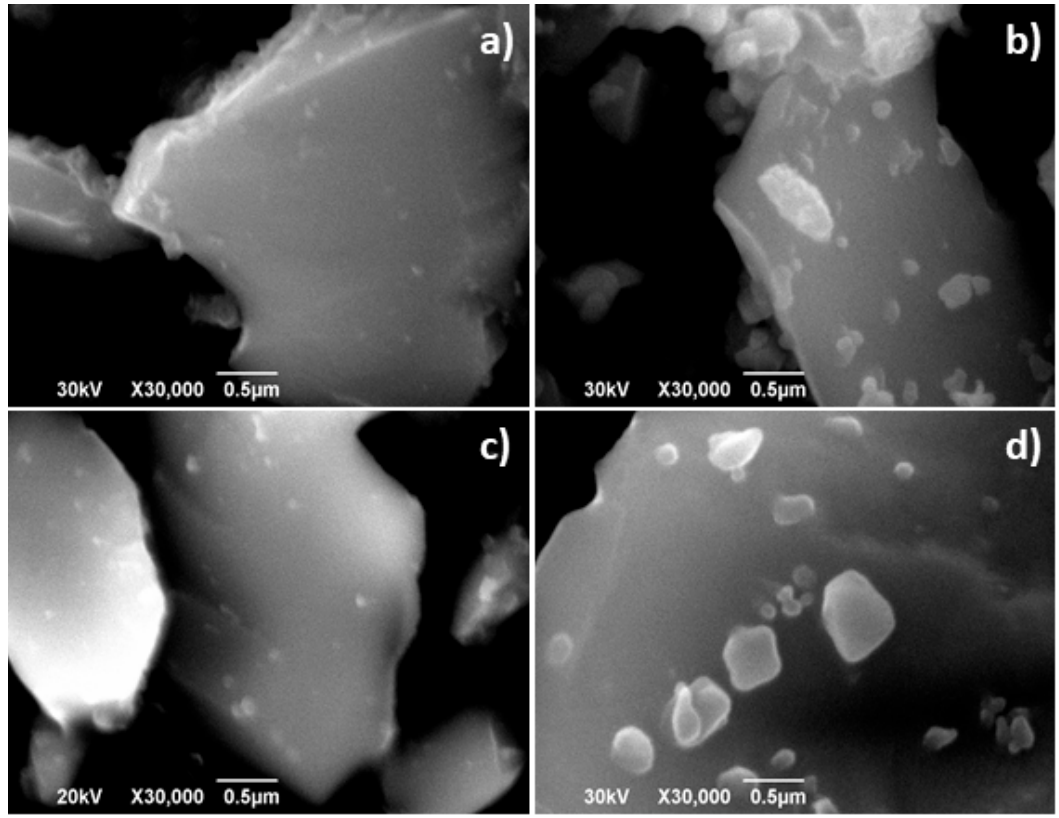
Figure 9. SEM images corresponding to ( a ) as prepared and ( b ) La 2 NiTiO 6 after annealing at 1173 K for 300 h and ( c ) as